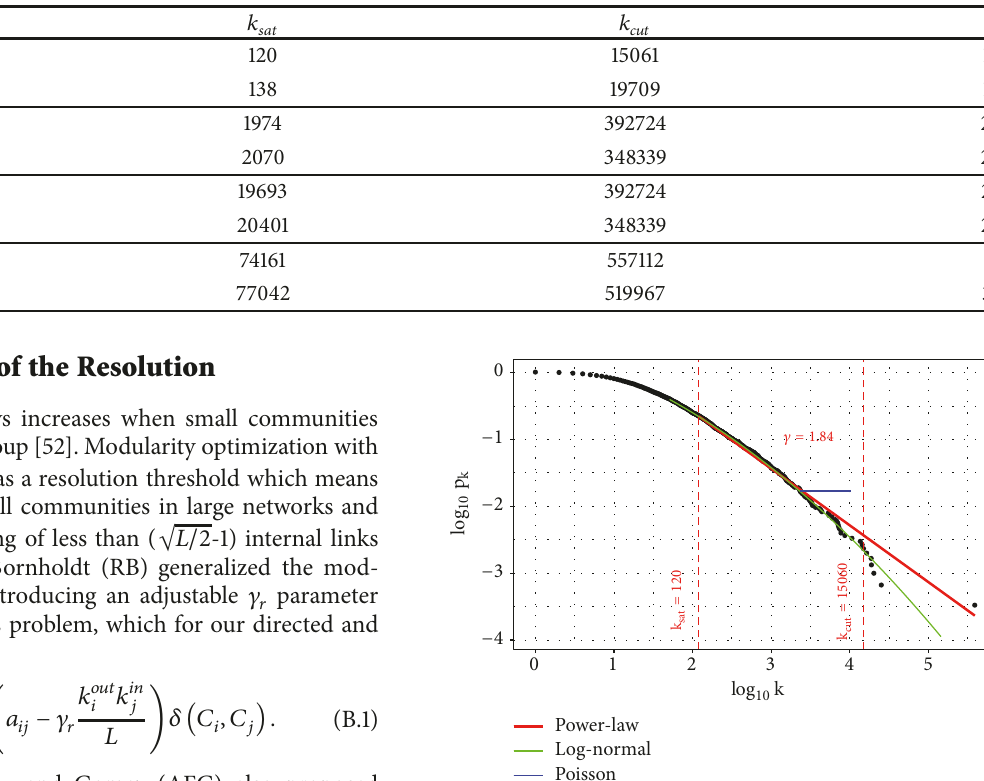
Table 4: Parameters of the power-law distributions fitted to networks at different settlement hierarchy levels.